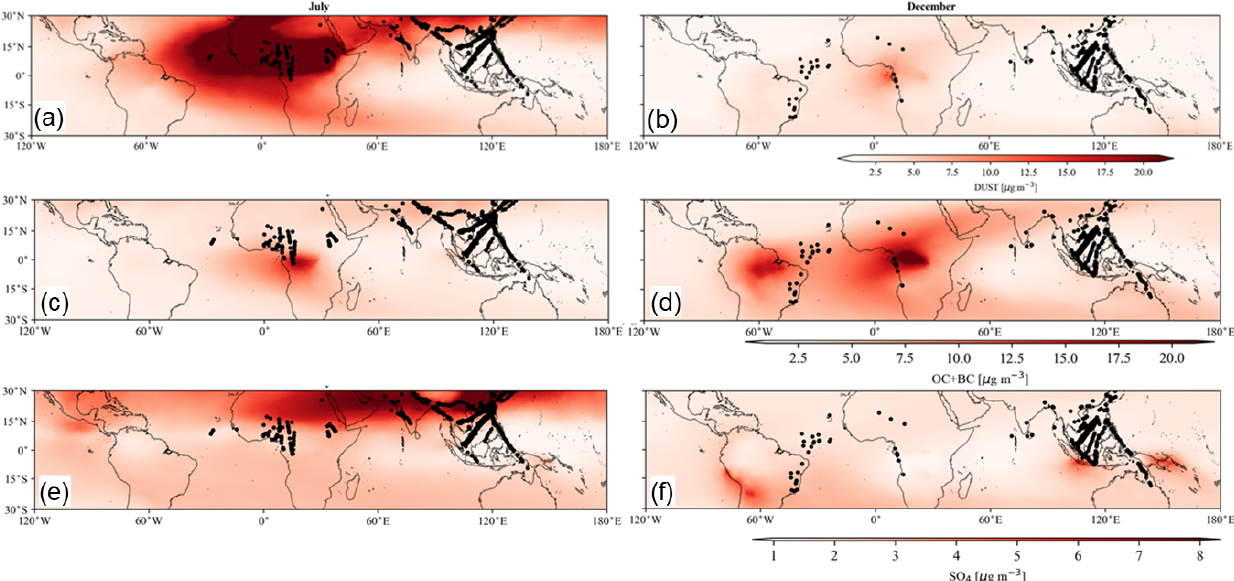
Figure 11. Average particle mass concentrations by aerosol composition for July (a, c, e) and December (b, d, f) , derived from MERRA-2 for (a, b) dust, (c, d) organic and black carbon (OC + BC), and (e, f) sulfate. These are average concentrations between 8 and 12km adjusted to standard temperature and pressure. The EIEs for July and December are shown as black markers.